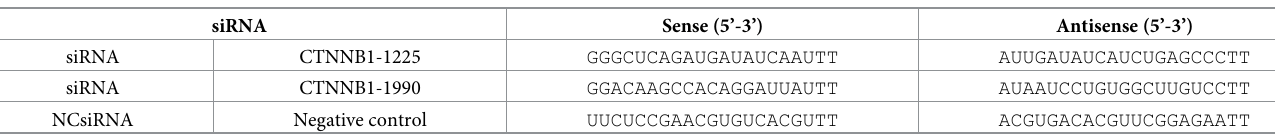
Table 1. siRNA sequence.